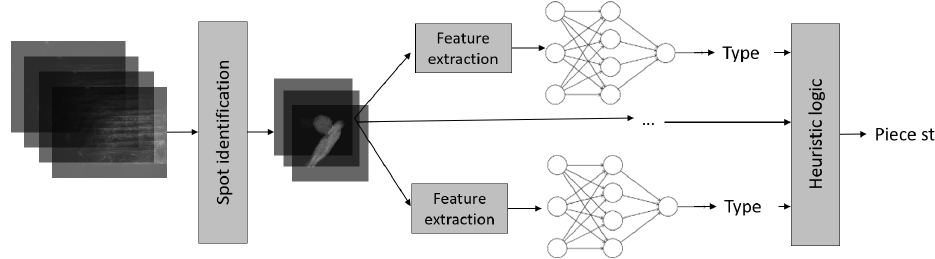
Figure 4. Second system architecture: deterministically extracted features from each spot are analysed with a neural